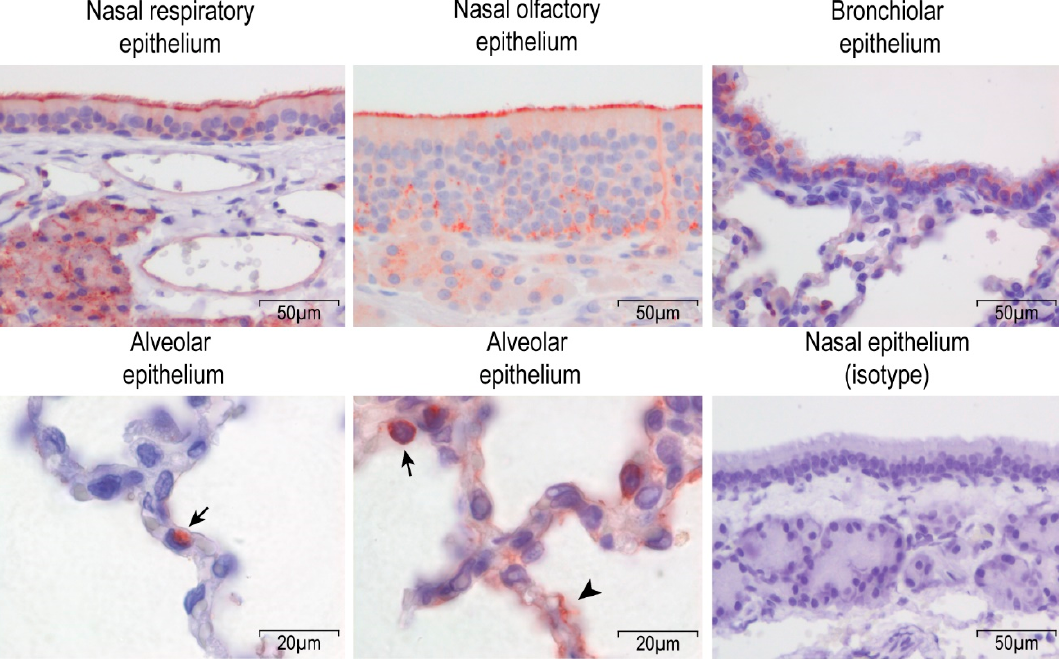
Figure 1. Dipeptidyl peptidase-1 (DPP4) expression in the respiratory tract tissues of rabbits. DPP4 is detected using immunohistochemistry and indicated in red in the figure. Type II cells are indicated with arrows, and type I cells with an arrowhead. Nasal epithelium and bronchiolar epithelium pictures were taken at a 400 × magnification, and alveolar epithelium at 1000 × . The isotype control showed no background signal in our